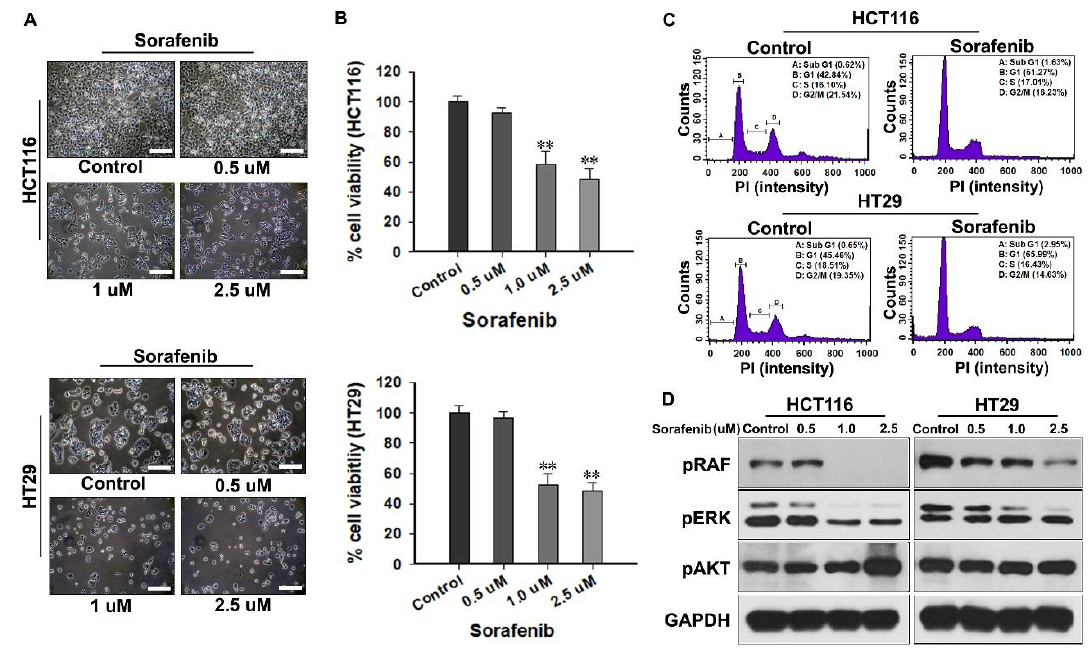
Figure 1. The antitumor effect on colorectal cancer (CRC) cells treated with different concentrations of sorafenib. ( A ) Morphological changes in CRC cells were observed using an optical microscope. Scale bars: 100 μm. Enlarged pictures are provided in Supplementary Figure S2. ( B ) Quantitative analysis of cell viability following treatment of CRC cells with increased concentrations of sorafenib. ( C ) Representative cell cycle profiles of the control and 2.5 μM sorafenib-treated CRC cells. ( D ) Immunoblots showing the suppressive effect of sorafenib on protein expression of phosphor(p) recombinant activated factor (RAF)/p extracellular signal-regulated kinase (ERK) but not for pAkt. Each blot was re-probed with anti-glyceraldehyde-3-phosphate dehydrogenase (GAPDH) antibody to ensure equal protein loading. All results were validated based on the quintuplicate analysis. ** p < 0.001 vs. Control. Results are mean ± standard deviation (SD).